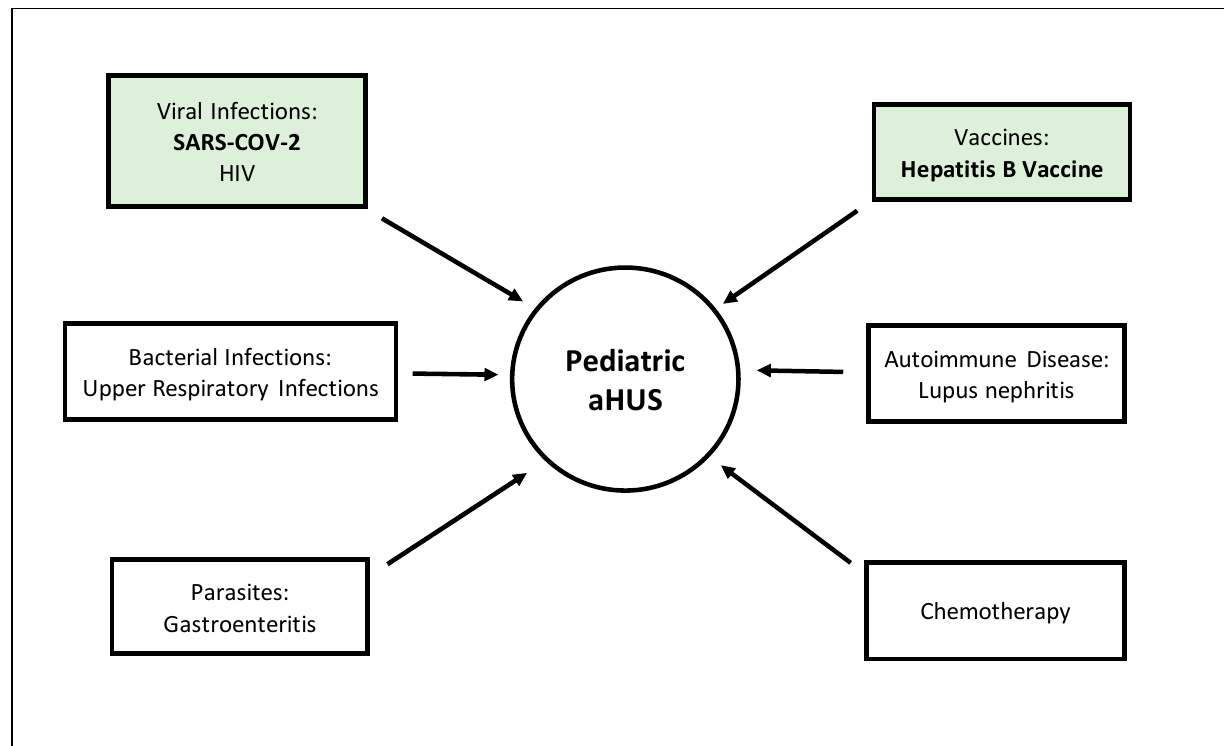
Figure 2. Atypical hemolytic uremic syndrome triggers. Novel developing triggers are highlighted in green. SARS-COV-2: severe acute respiratory syndrome coronavirus 2; HIV: human immunodeficiency virus.